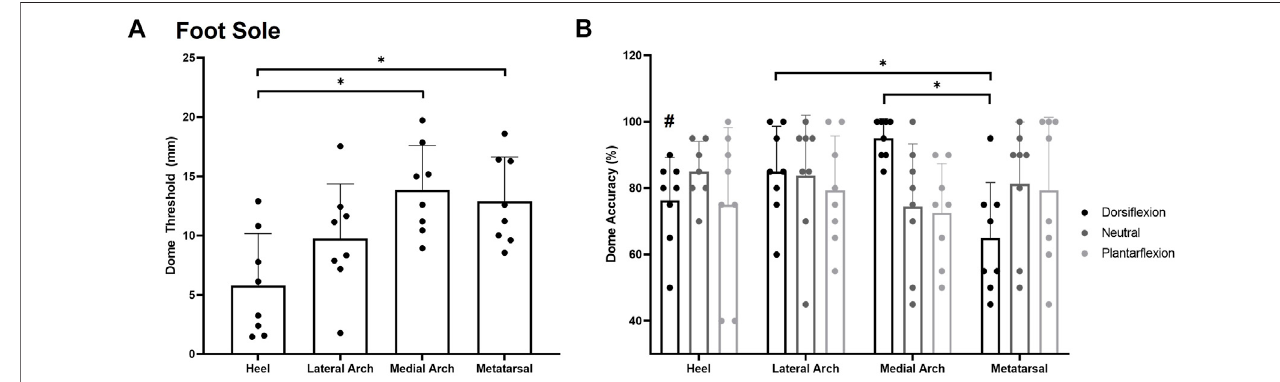
FIGURE5| Mean(+SD)spatialacuitythresholdacrosseach ofthefootsoletestinglocations (A) .Asterisksindicate statisticallysigni fi cantdifferencescompared to theheeltestsite( p < 0.05).Mean(+SD)domedetectionaccuracyacrosseachofthefootsoletestinglocationsinthevariouspostures (B) .Asterisksindicateasigni fi cant difference compared to the metatarsal site in the dorsi fl exion posture ( p < 0.05). Pound symbol indicates a signi fi cant difference compared to the medial arch in the dorsi fl exion posture ( p < 0.05). Dots represent threshold values for each participant. Note Figure A is in mm, where lower numbers signify greater sensitivity. Figure 5B is in % accuracy, where higher values indicate greater sensitivity.